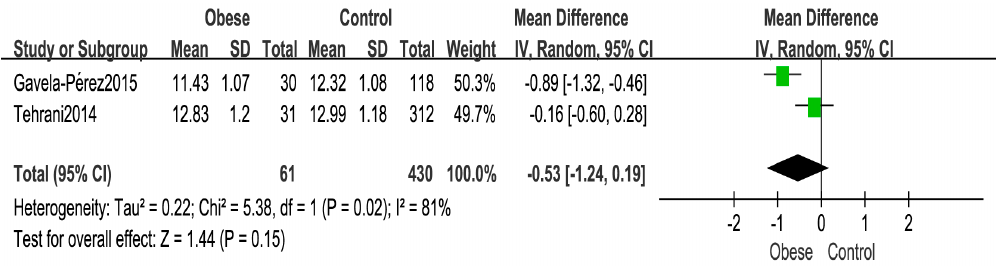
Figure 2. Forest plot for the age at menarche between the obese and normal weight control girls.